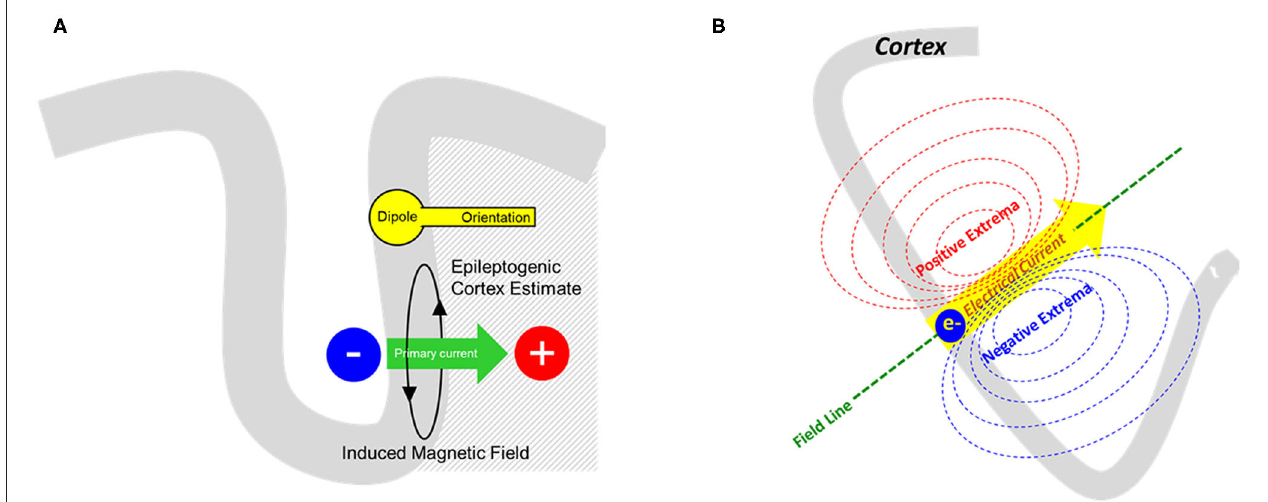
FIGURE 1 | (A) From the measured magnetic field, an equivalent current dipole model can solve the inverse problem and provide a representation of primary current as shown here. The cortical source is represented by rounded dipole (a.k.a. “head”) whereas the direction of primary current flow (green arrow) is represented by the